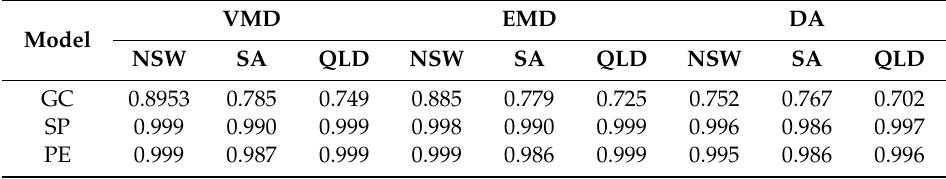
Table 7. Correlation coe ffi cient between new sequence and original